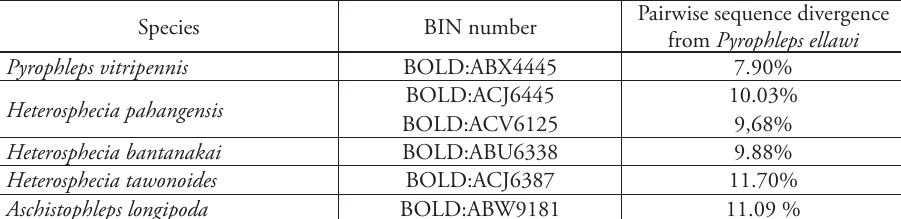
Table 1. COI pairwise sequence divergence of species closely related to Pyrophleps ellawi with Barcode of Life BIN numbers. Multiple alignment of the compared sequences is shown in Supplementary material